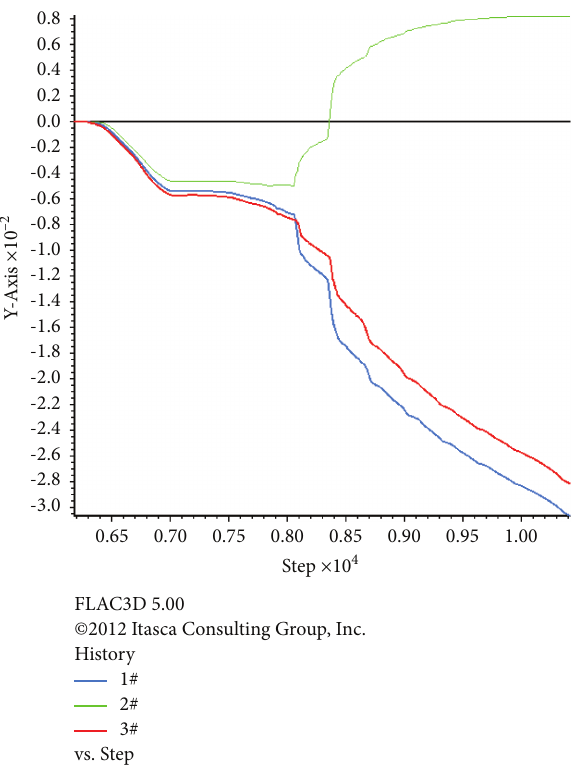
Figure 19: Vertical displacement curve of tunnel roof. Table 6: Mining stress and deformation of surrounding rock under different working conditions. Horizontal displacement